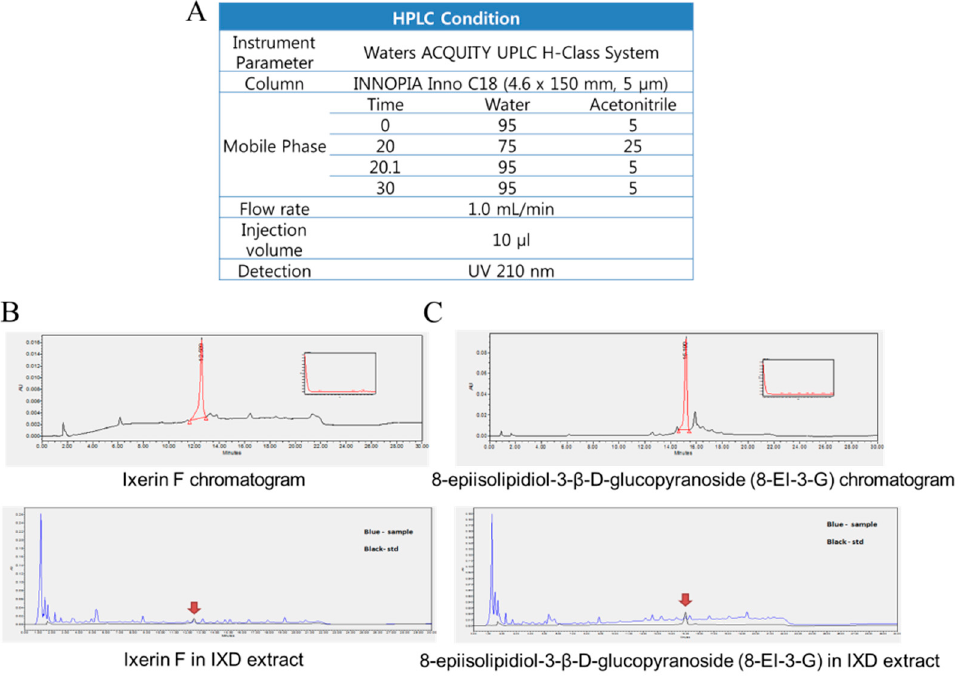
Figure A1. ( A ) HPLC conditions used in the quantitation of pure compounds from the IXD extract; ( B ) Chromatogram of Ixerin F; ( C ) Chromatogram of epiisolipidiol-3- β - D -glucopyranoside (8-EI-3-G).